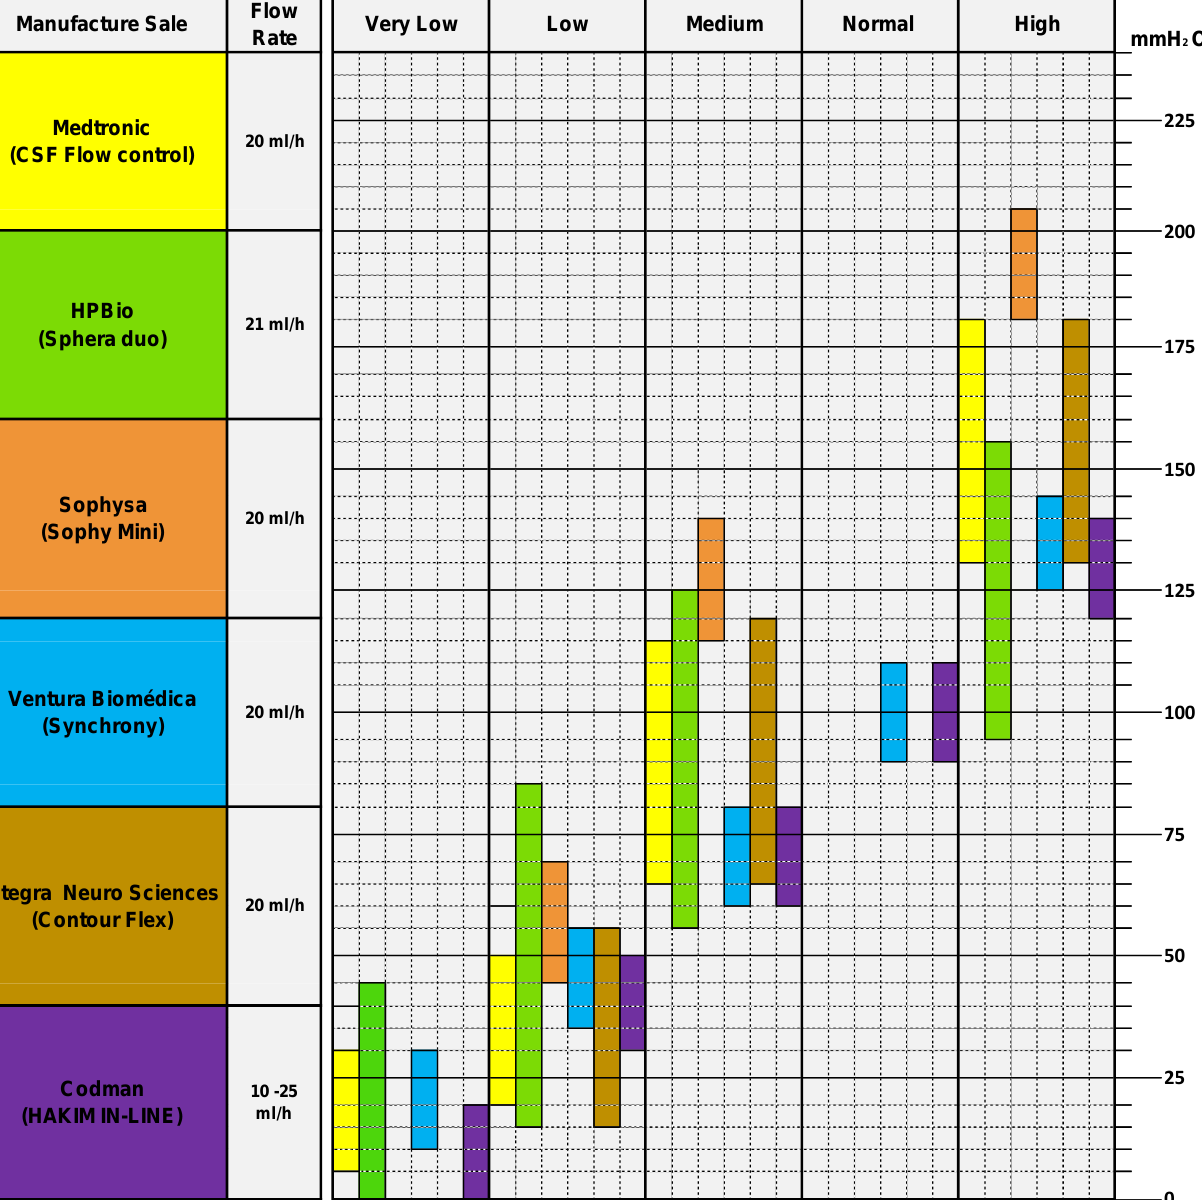
Graphic 1: Shunt Pressure Equivalency graphic table: Shunt manufacturers were given a different colour to be identified at the graphic, on the left side. Each small square represents 5 mm H 2 O. Each block represents a very-low pressure shunt, low pressure shunt, medium pressure shunt, and high-pressure shunt. Each column within the pressure block identifies the manufacturer by the colour. Pressure range for each shunt is represented by the vertical-coloured column for each pressure setting and shunt manufacturer. Pressure in mmH 2 O is identified on the right